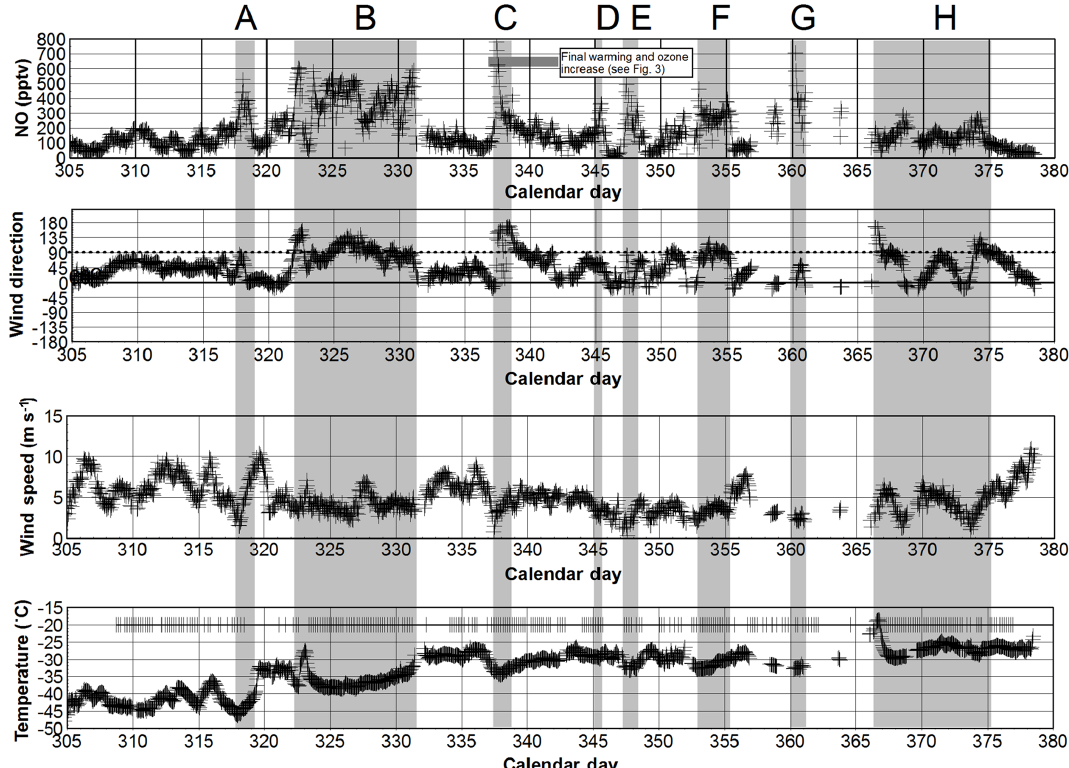
Figure 7. Time series of NO, wind direction, speed and 2m temperature for November 2006 through mid-January 2007 (Days 305–380). Data gaps at the end of December are due to either missing NO and/or meteorological data. Shaded areas and labels A–H are cases where NO > 300pptv. Case “C” is that highlighted in Fig. 5 which occurs at the time of stratospheric warming and total column ozone increase. The wind azimuth of 60 ◦ is also noted (corresponding to Fig. 4 for directions associated with higher NO). Periods of clear skies are indicated on a four-hourly basis by hash marks at − 20 ◦ C on the temperature plot: note the increase in temperature around JD320 associated with cloudy skies, increase in wind speed, and shift in wind direction from east to